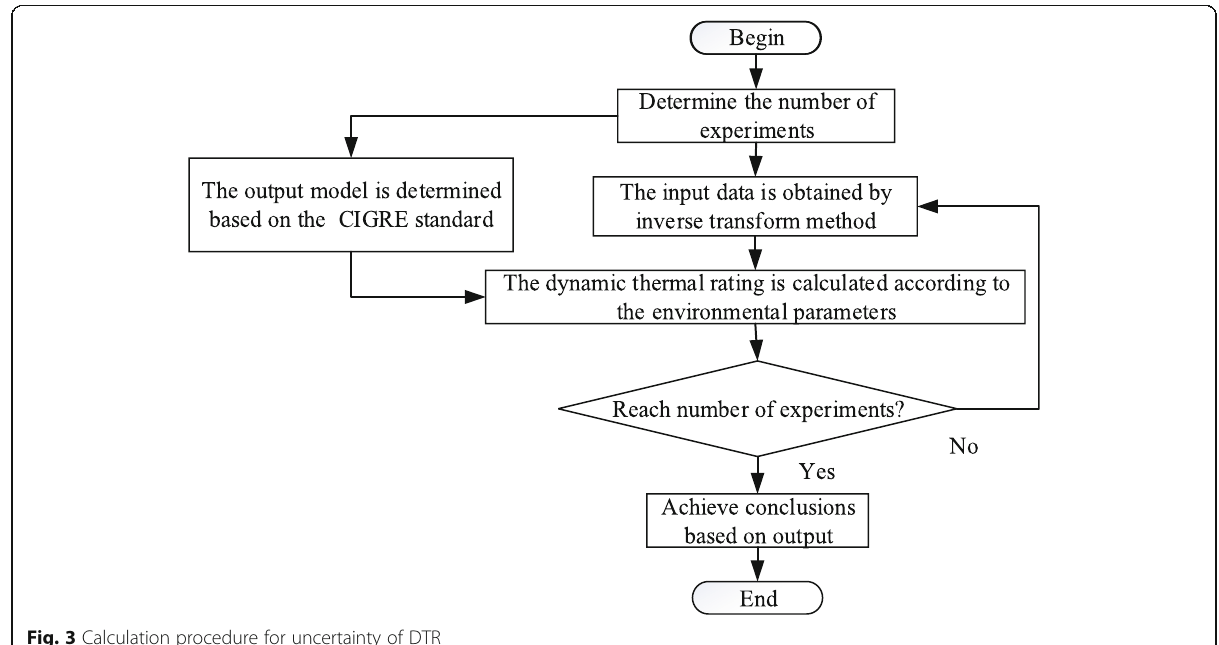
Fig. 3 Calculation procedure for uncertainty of